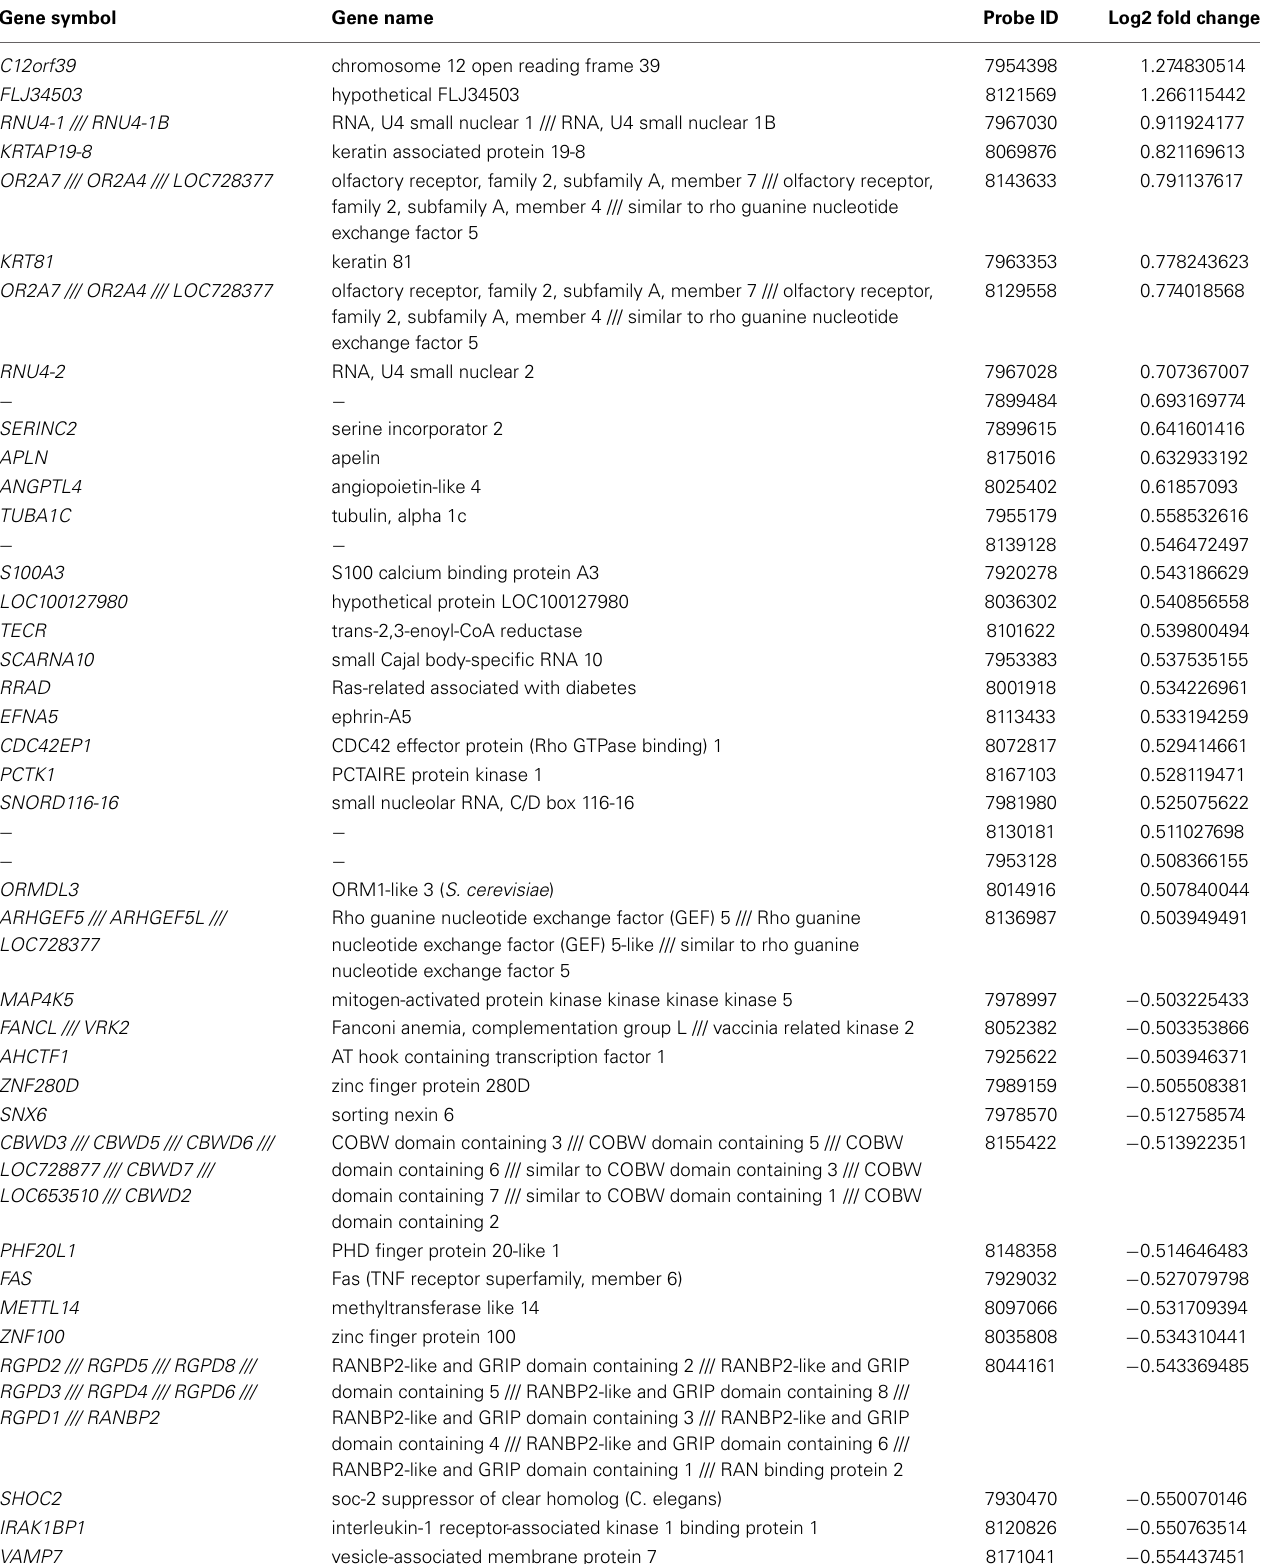
Table 7 | Significantly up and down regulated genes in the control vs. SSRI groups ( − = reduction in expression levels). Gene